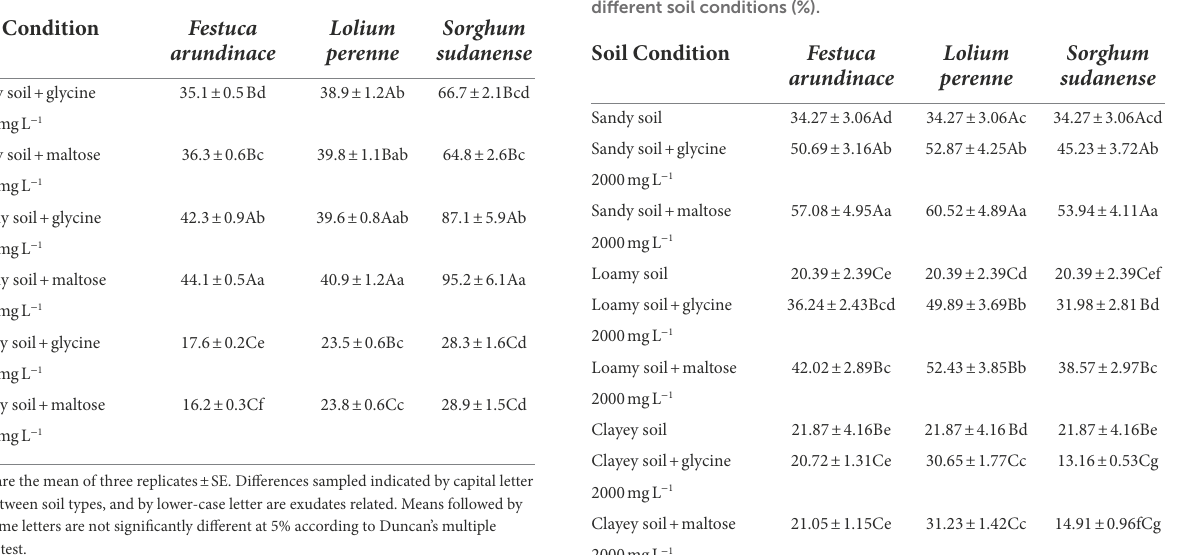
TABLE 5 Plant height under different soil conditions (cm).